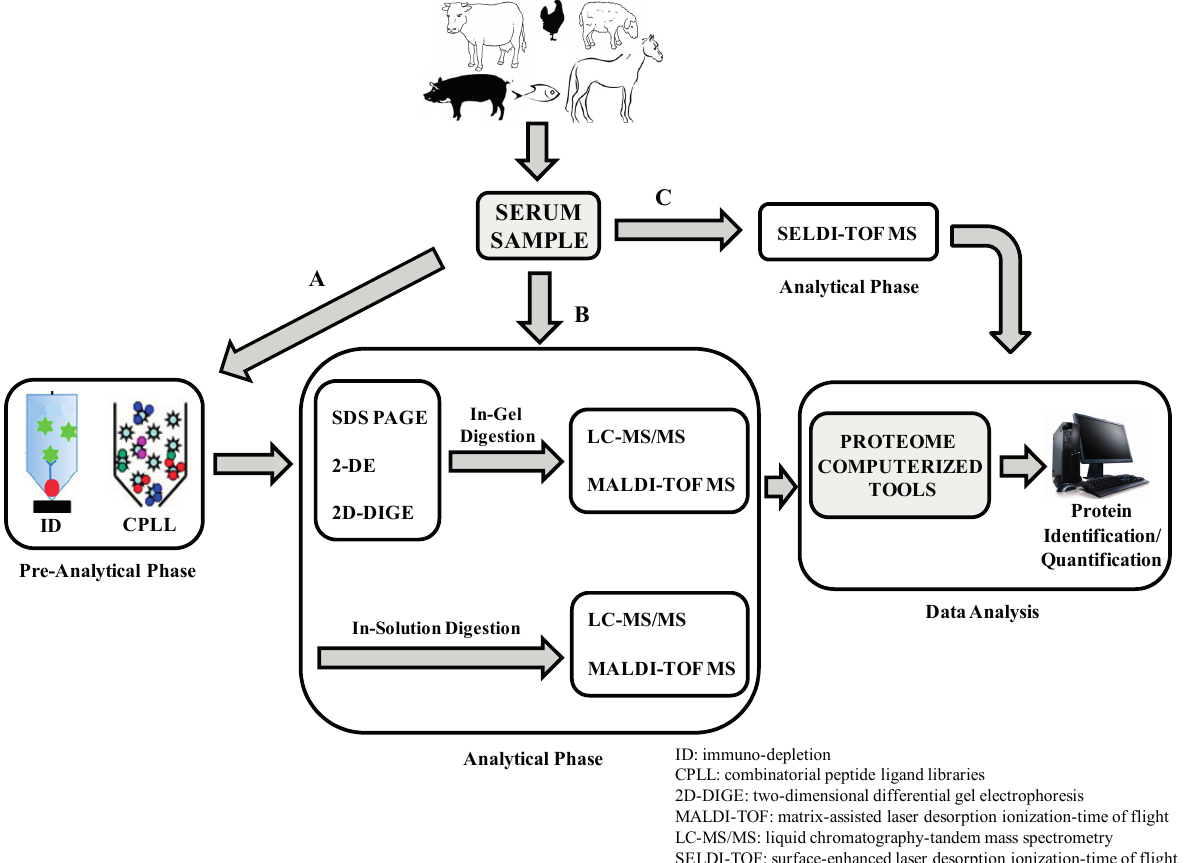
Figure 1. Routinely pre-analytical and analytical approaches for farm animal serum proteomic studies. Serum samples could be pre-treated ( A ) to reduce the high dynamic range in protein concentration, or not pre-treated ( B , C ) and, subsequently, analyzed through electrophoretic, chromatographic and mass spectrometric platforms. The large amount of data produced are, then, processed by sophisticated bioinformatic algorithms for qualitative and quantitative proteomic